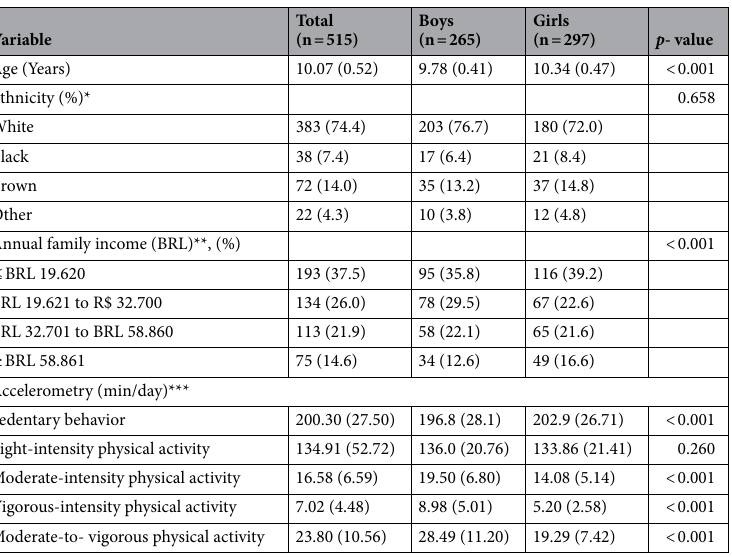
Table 2. Descriptive analysis (mean [SD] or n [%]) of socio-demographic and accelerometry variables. SD standard deviation. *(%) percentage. ** BRL Brazilian real. *** min/day minutes per